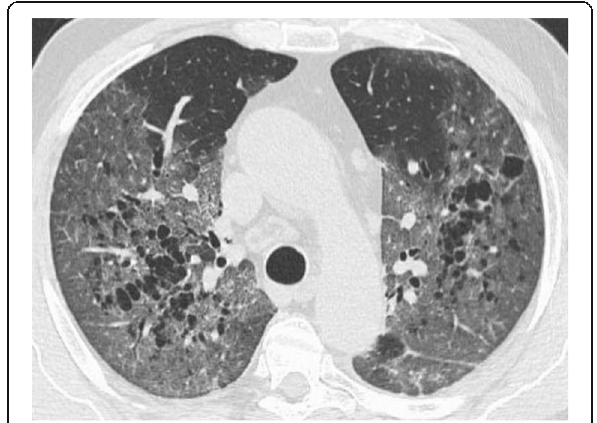
Fig. 7 CT scan of COVID-19 patient shows reticular pattern superimposed on the background of GGO with nodular shadows and bilateral small cystic changes at upper lobes